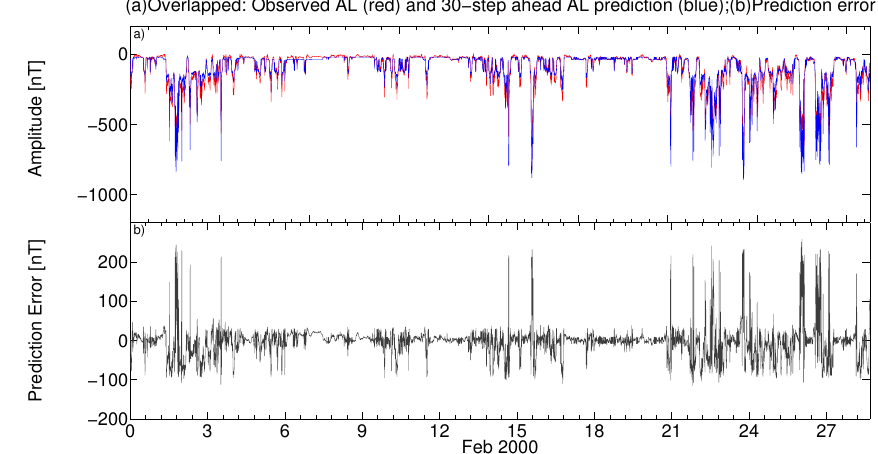
Fig. 6. (a) AL observation (red) and predicted AL (blue) – 30 step ahead prediction; (b) prediction error. The panel shows one month of data (February 2000) at 1min resolution.